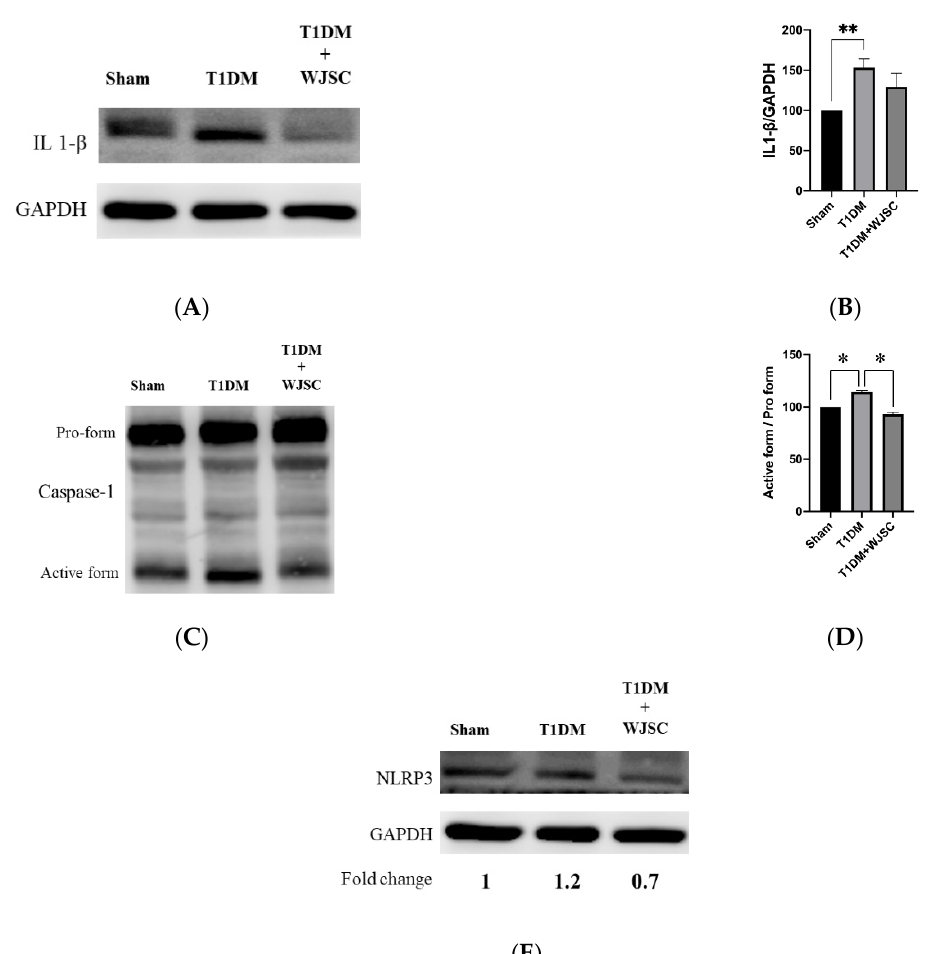
Figure 5. Exploring inflammasome related markers for heart tissues using western blotting analysis. ( A ) IL ‐ 1 β protein expression; ( B ) quantification of IL ‐ 1 β expression; ( C ) Caspase ‐ 1 protein expres ‐ sion; ( D ) quantification of caspase ‐ 1 expression; ( E ) NLRP3 protein expression. * p < 0.05; ** p <